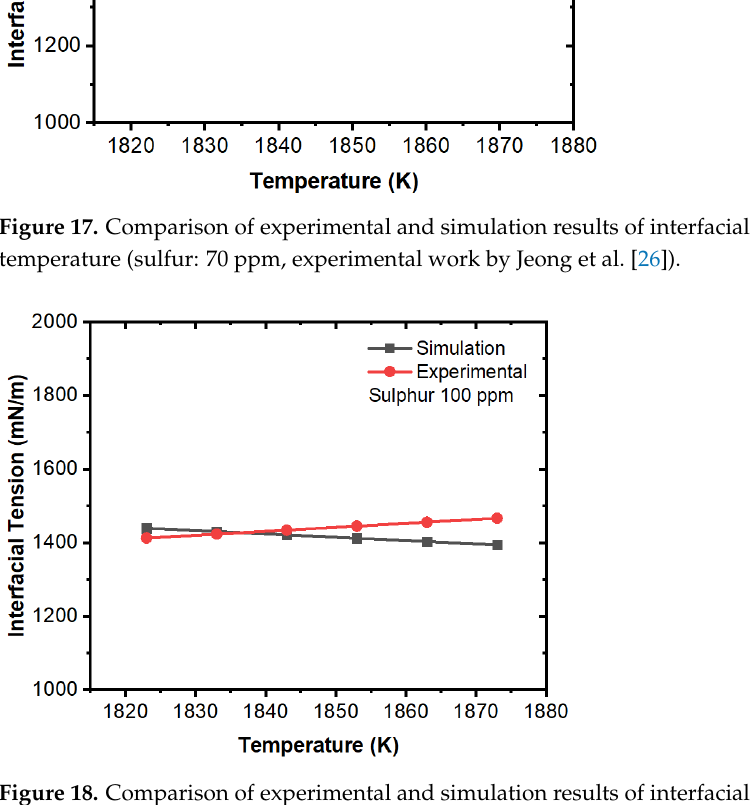
Figure 18. Comparison of experimental and simulation results of interfacial tension with respect to temperature (sulfur: 100 ppm, experimental work by Jeong et al. [26]).